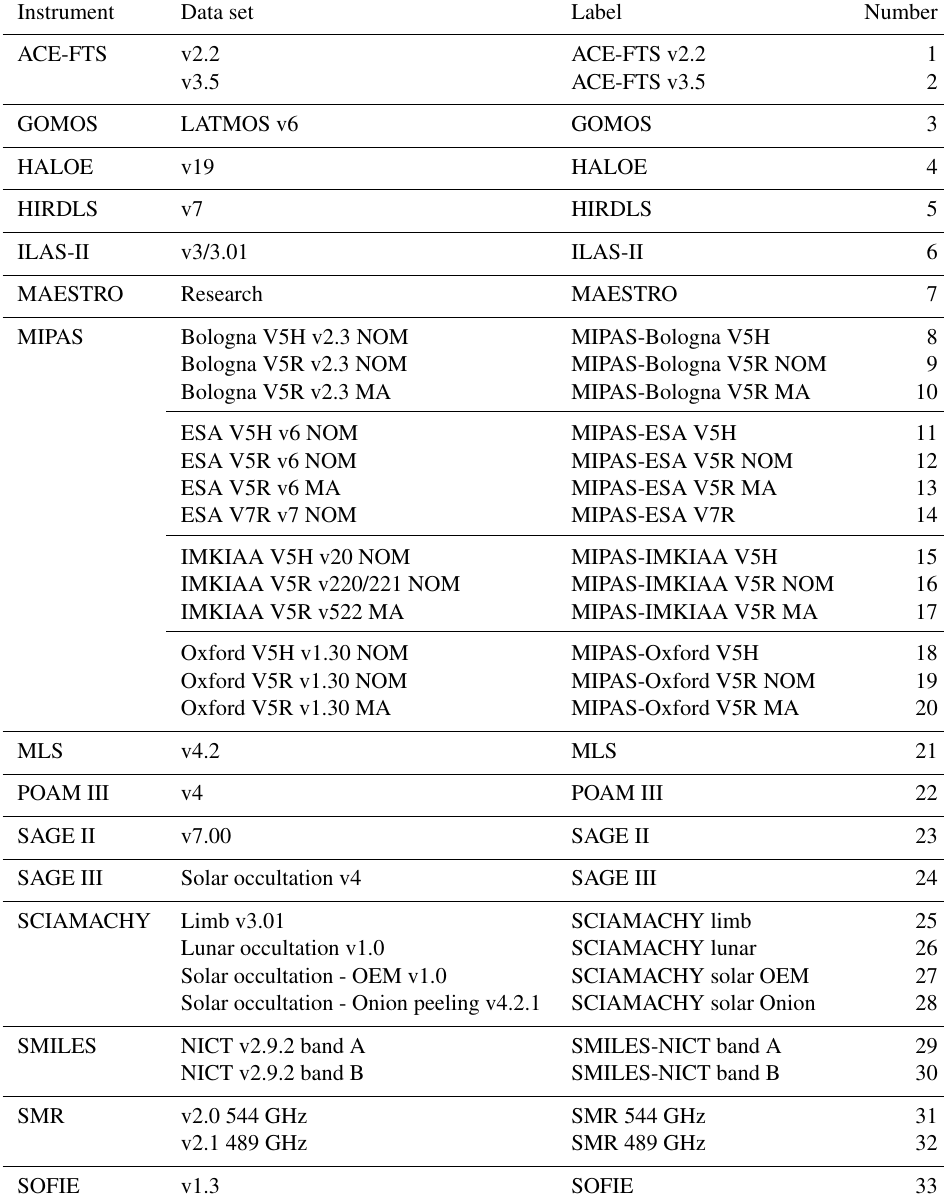
Table 1. Overview of the water vapour data sets from satellites used in this study.